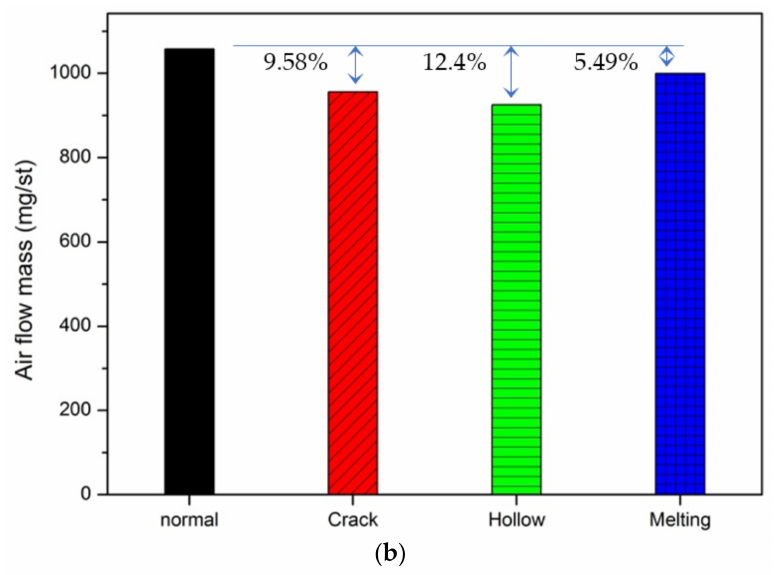
Figure 9. Comparison of air-flow mass rate by GDS signal for 4 types of DPF sample. ( a ) Variation in air-flow mass during KD-147 driving mode (black line) ( b ) Difference of maximum air-flow mass value.